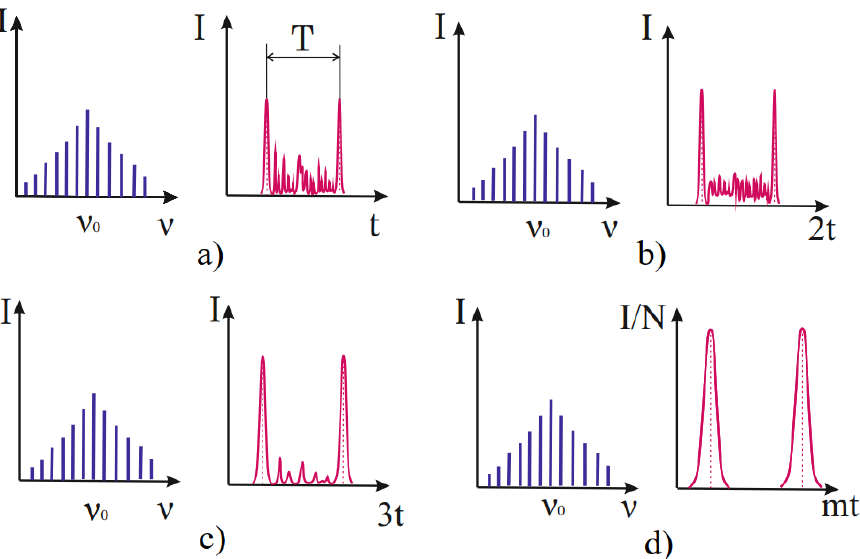
Figure 8. The pulse formation occurs at once at all frequencies of the laser band: ( a ) shows the evolution of the laser radiation parameters after the first pass of the cavity; ( b , c ) after the second and third, respectively; ( d ) already shows the result of the saturable absorber after a large amount of radiation passes through the cavity.